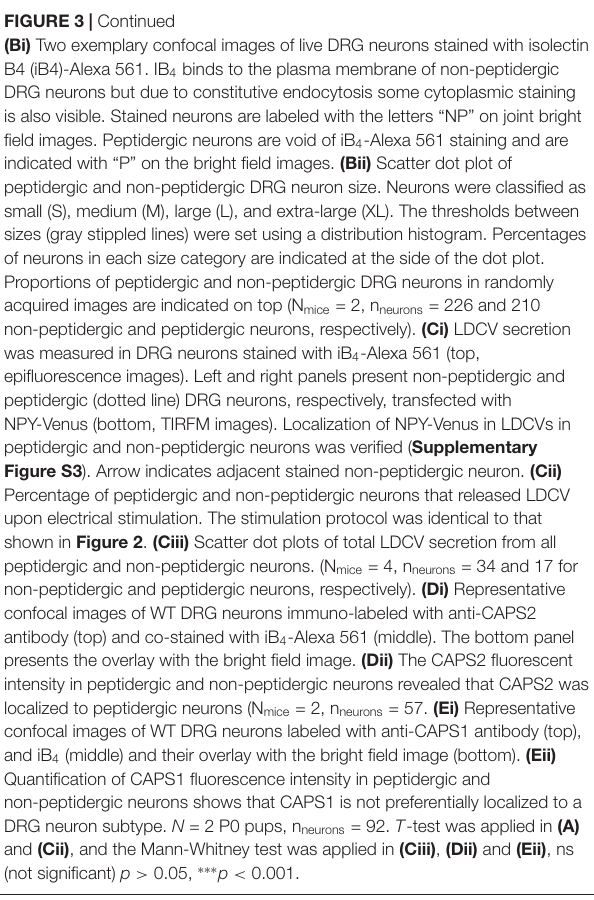
DRG neuron subtype. N = 2 P0 pups, n neurons = 92. T -test was applied in (A) and (Cii) , and the Mann-Whitney test was applied in (Ciii) , (Dii) and (Eii) , ns